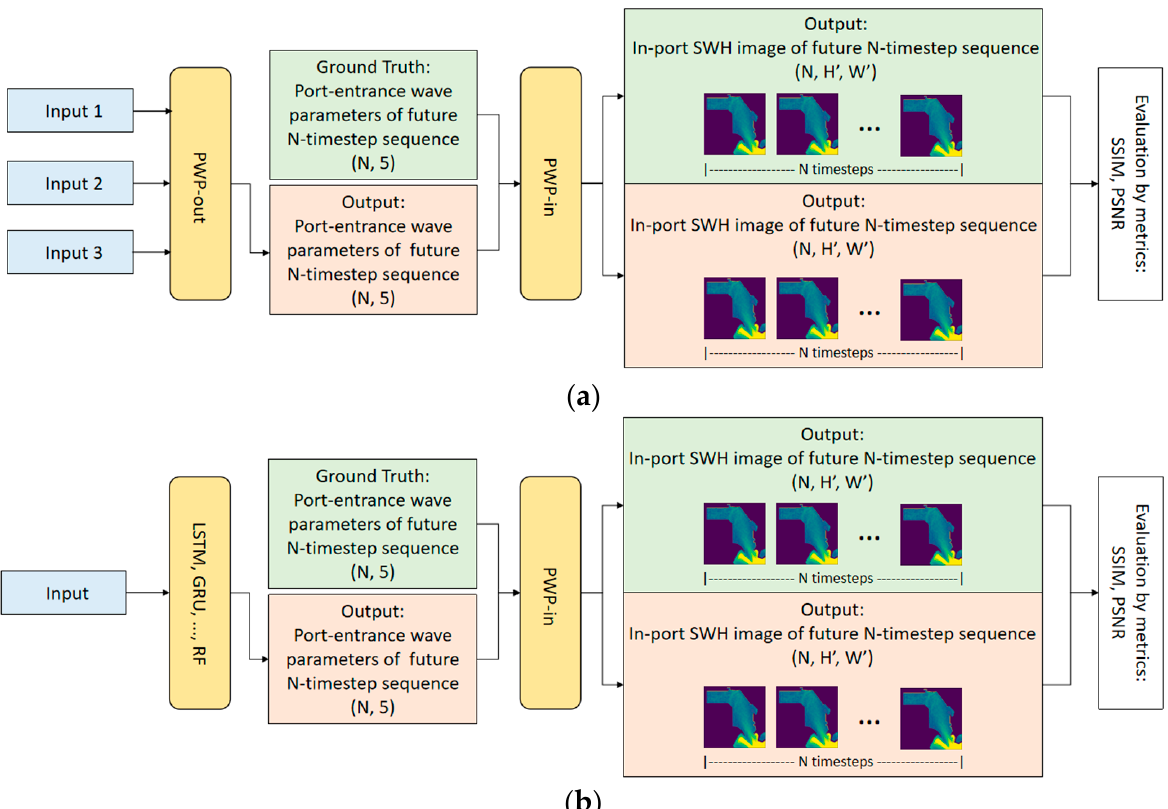
Figure 11. A schematic diagram of testing PWPNet ( a ) and other 2-stage models ( b ).